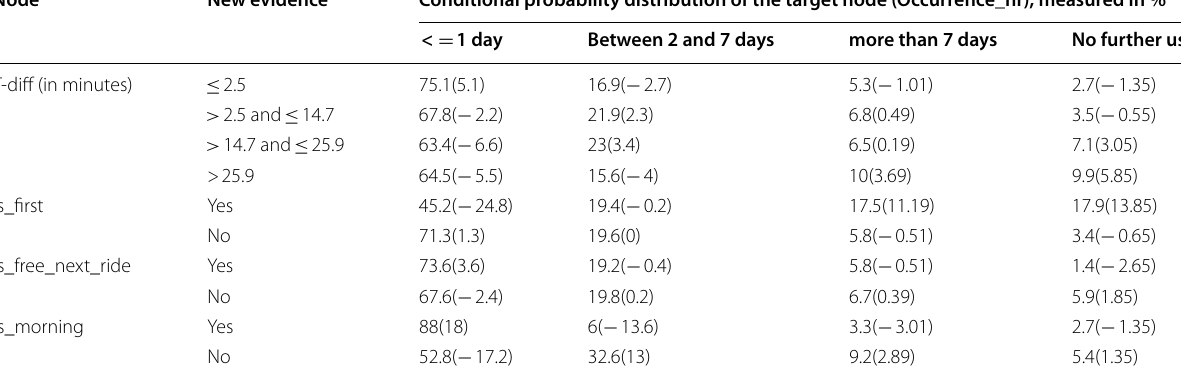
Remark The numbers in parentheses are the probability changes with respect to the case without new evidence from other nodes of the BN, i.e., 0.7 (< (2–7 days), 0.0631 ( ≥ 7 days), and 0.0405 (no further use)